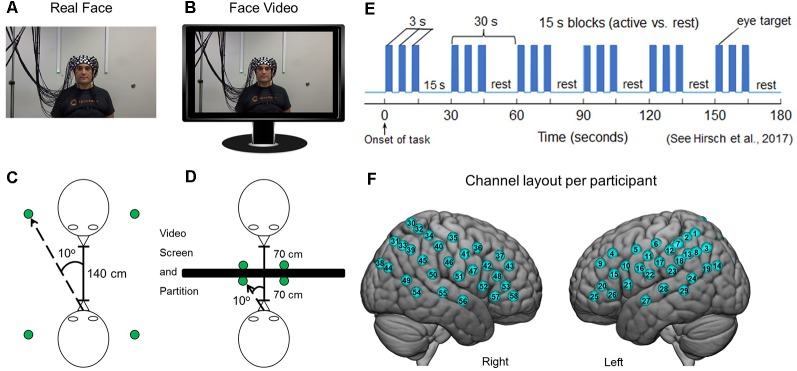
Experimental conditions. (A) Subjects were set up with 58 functional near-infrared spectroscopy (fNIRS) channels distributed bilaterally on the heads of both participants, who were seated across from each other so that each individual in a dyad could see the face of their partner. A small green Light Emitting Diode (LED) indicator lights located to either side of their partner indicated rest gaze targets. (B) Twenty-four-inch 16 × 9 monitors were placed between subjects and a size-calibrated, pre-recorded face video was presented in the same field of view as the live interaction. (C) Diagrammatic representation of dyadic interaction. Subjects were 140 cm apart from each other and the LED indicator lights placed 10° to the left and right of the face. (D) In the face-video condition, a partition was placed between subjects and monitors were arranged in the field of view of both partners. The face and LED sizes and positions were calibrated to subtend the same visual angles in both conditions. (E) Time course of the experimental paradigm. The entire duration of the run was 3 min and was repeated twice each for both the live interaction and the video face interaction. During the 3-min interaction, participants alternated between 15-s task and rest periods. In the task period, participants looked either directly at the eyes of their partner or at the left or right LED that was lit. During the rest period, subjects looked only at the lighted LED. The task was modified from one that has been used previously (Hirsch et al., 2017). (F) Optical channel layout for both hemispheres of each participant. The median locations of each channel are shown in Supplementary Table S1. Written informed consent was obtained from the individual for the publication of the images shown in panels (A,B).